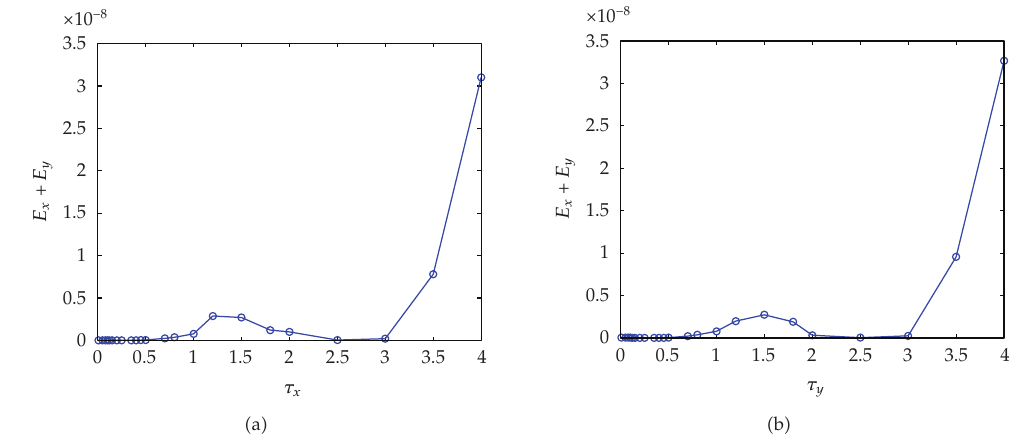
Figure 3: The plot shows E x (cid:8) E y at t (cid:7) 40 with regard to τ x or τ y , (cid:2) a (cid:3) τ y (cid:7) 0 . 8; (cid:2) b (cid:3) τ x (cid:7) 0 .